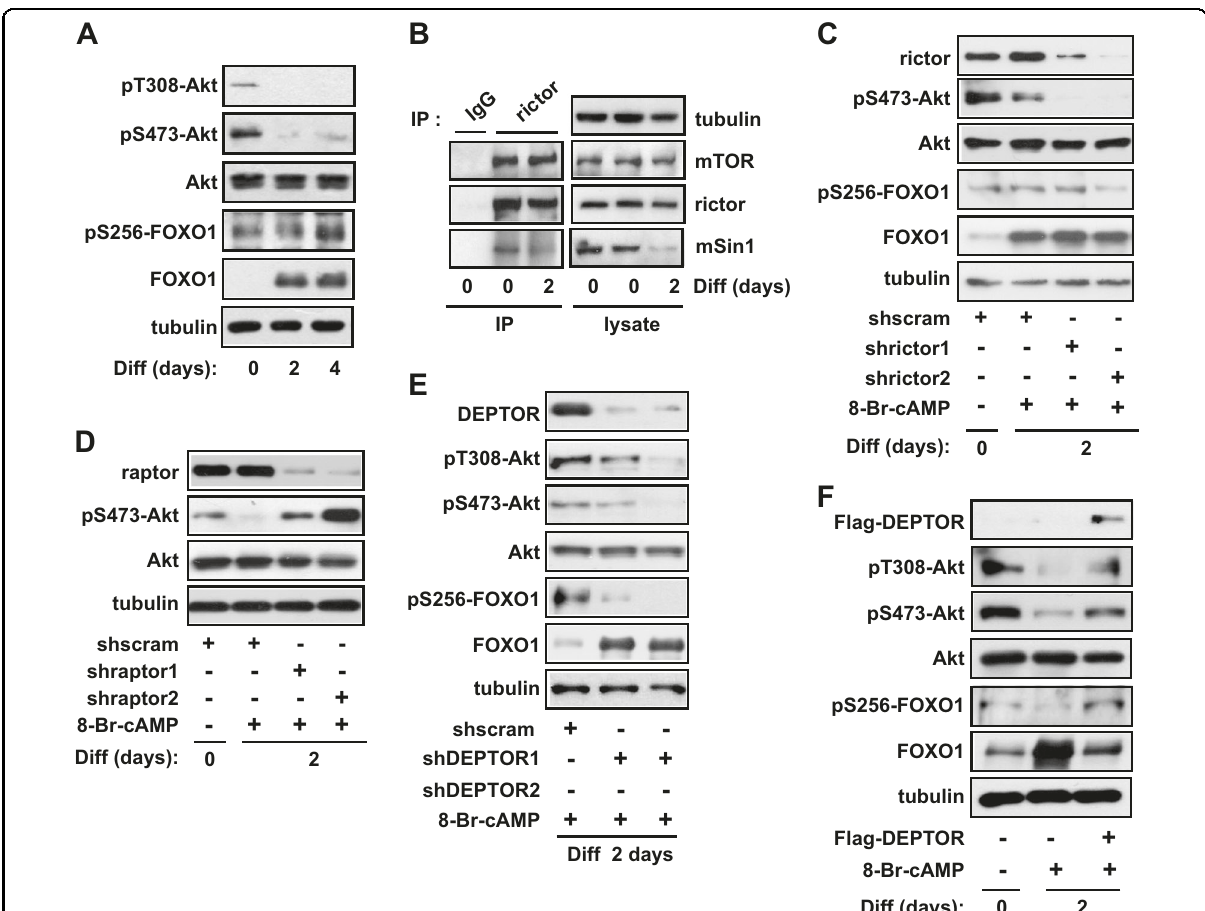
Fig. 5 Differential regulation of mTORC1 and mTORC2 inactivates Akt, accompanied by decreased pS256-FOXO1 during 8-Br-cAMP- induced decidualization. a Human endometrial stromal (hES) cells were differentiated with 8-Br-cAMP for 4 days, lysed, and analyzed by western blotting. b On day 0 or 2 of 8-Br-cAMP-induced differentiation, hES cells were lysed, subjected to immunoprecipitation against rictor, and analyzed by western blotting. c – e Cells were infected with rictor shRNAs ( c ), raptor shRNAs ( d ), DEPTOR shRNAs ( e ), or scrambled shRNA; cells were then selected by puromycin for 5 days. Cells were differentiated in the presence of 0.5 mM 8-Br-cAMP, lysed, and then subjected to western blotting. f Cells were transfected with Flag-DEPTOR, differentiated with 0.5 mM 8-Br-cAMP for 2 days, lysed, and then subjected to western blotting. All blots are representative of three to fi ve independent